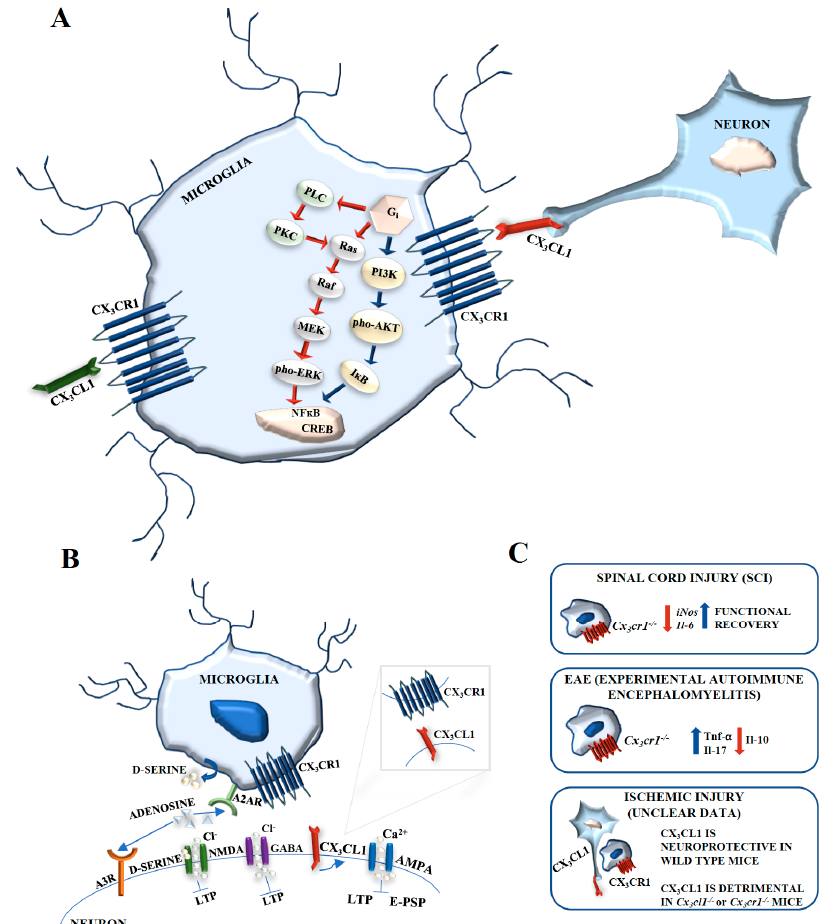
Figure 4. CX3CL1-CX3CR1 signaling. ( A ) CX3CL1 induces transient phosphorylation of Akt and